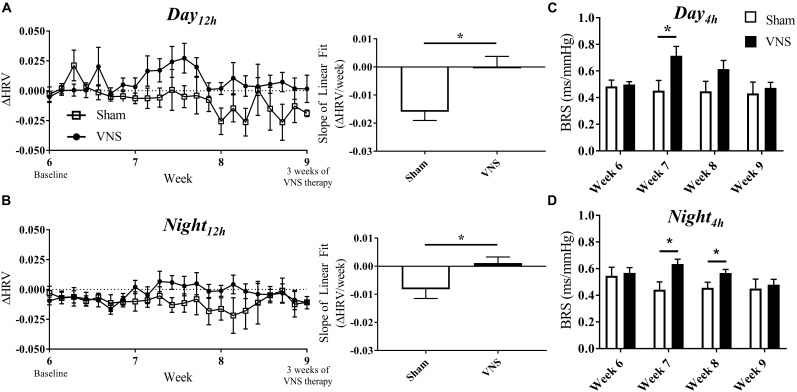
Relative changes in HRV (ΔHRV) as HTN progresses. ΔHRV as a function of time and slopes of the linear regressions are shown for Sham and VNS rats during the (A)
Day12h interval and (B)
Night12h intervals. BRS was quantified during the Day4h
(C) and Night4h
(D) intervals for Week 6 through Week 9. ∗Indicates statistical significance between Sham and VNS rats.